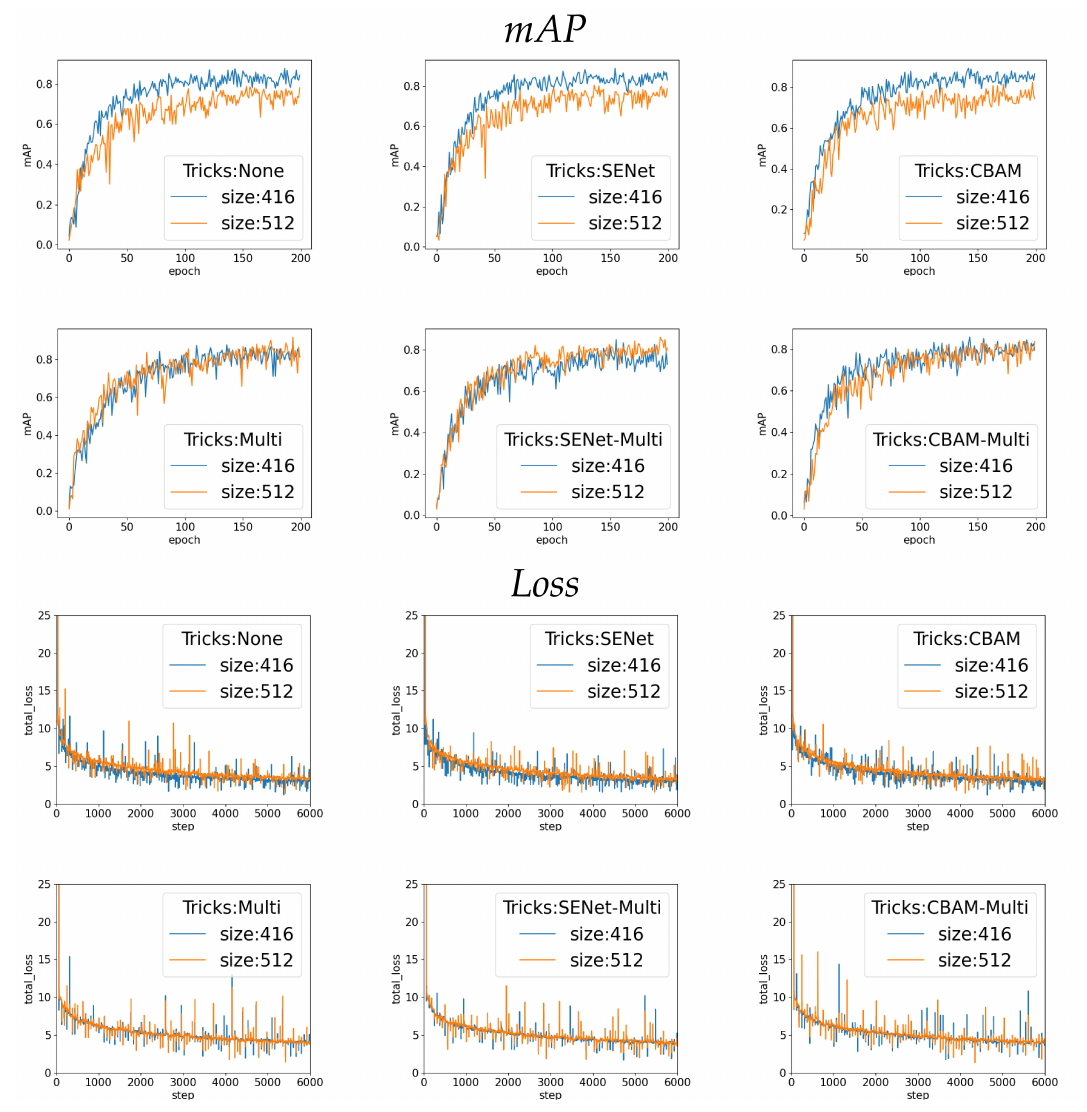
Figure 4. Changes in mAP and loss in each group of experimental